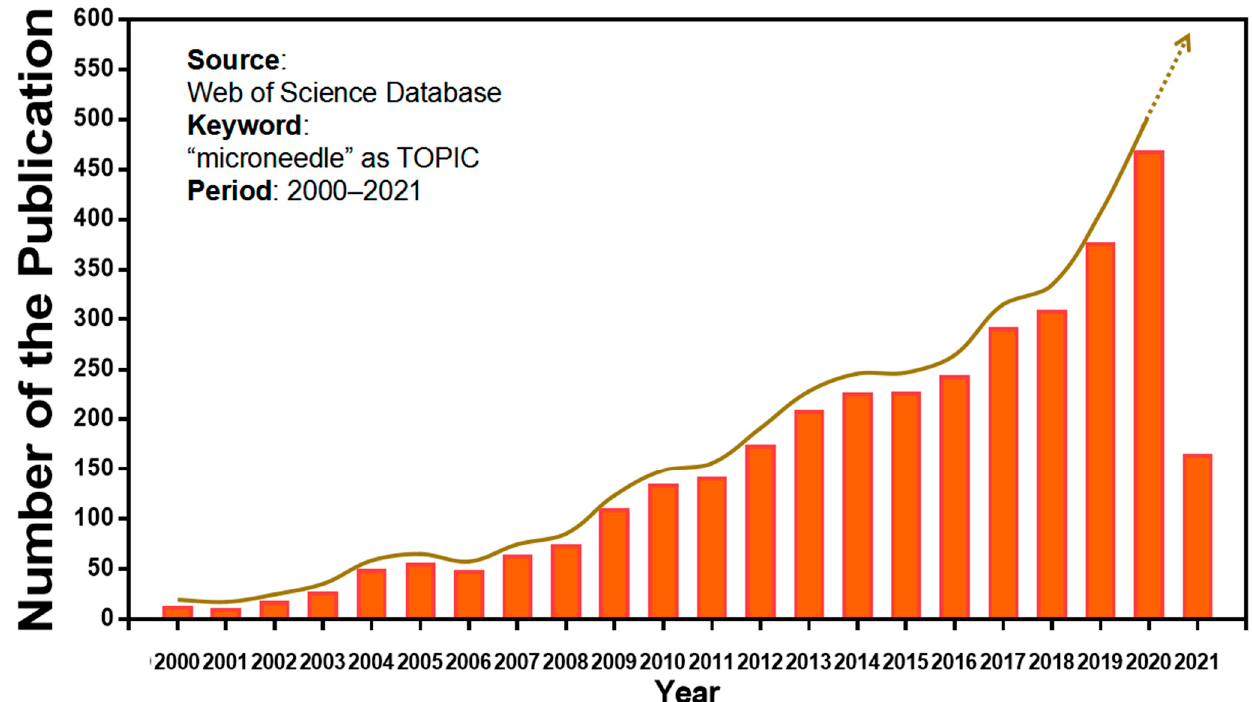
Figure 3. Keyword literature search of microneedles in Web of Science. The popularity of microneedles has been growing every year from 2000 until now.